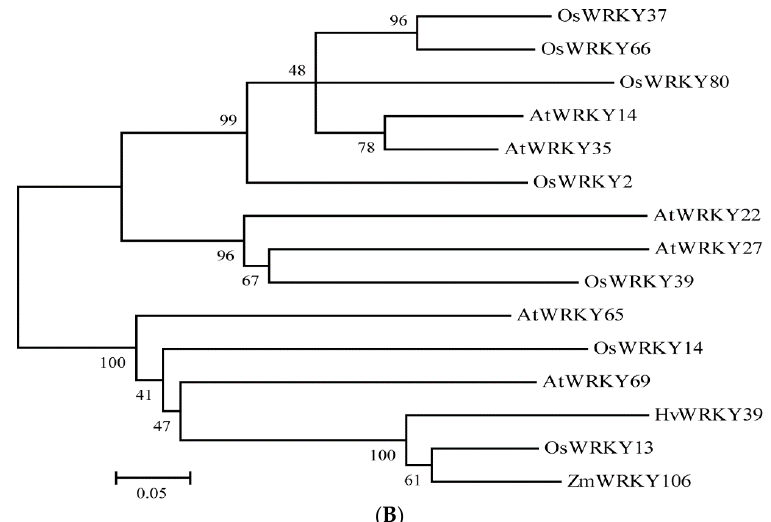
Figure 2. Multiple alignment and phylogenetic relationships of ZmWRKY106 with other orthologs in rice, Arabidopsis , and barley. The phylogenetic tree was produced using the aligned file with 1000 bootstraps in the MEGA 5.0 program. ( A ) Multiple alignment of ZmWRKY106 homologous proteins in rice, Arabidopsis , and barley. The different background colors represent the similar degree of amino acid sequences. ( B ) Phylogenetic relationship of ZmWRKY106 and other orthologs in different species. The first red box indicates the WRKYGQK motif, and the second indicates the conserved C2H2 zinc-finger motif.